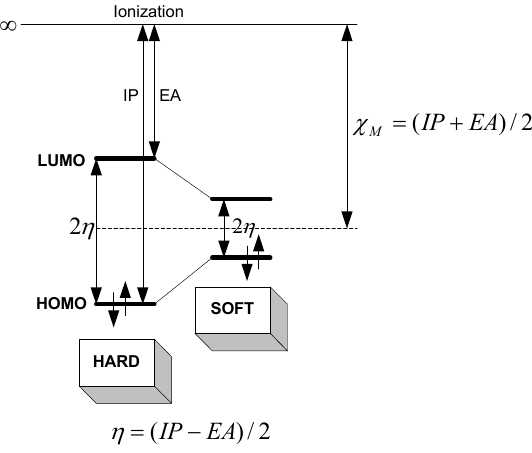
Figure 1 . DFT-derived descriptors and orbital energy diagram.